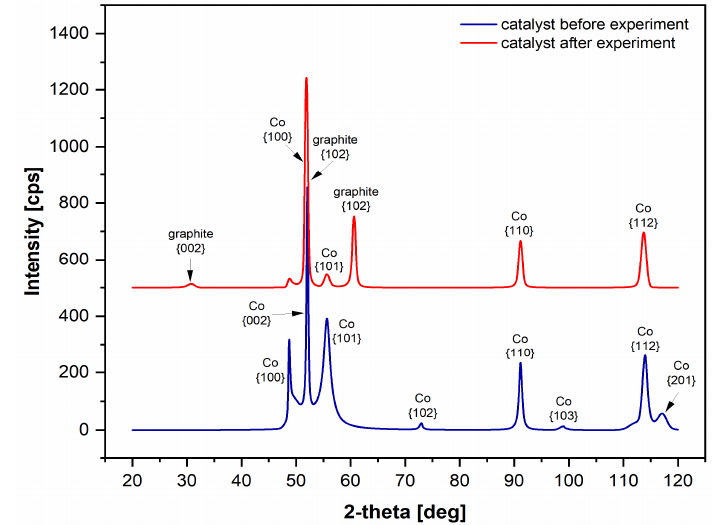
Figure 6. XRD patterns of the fresh and used catalyst.